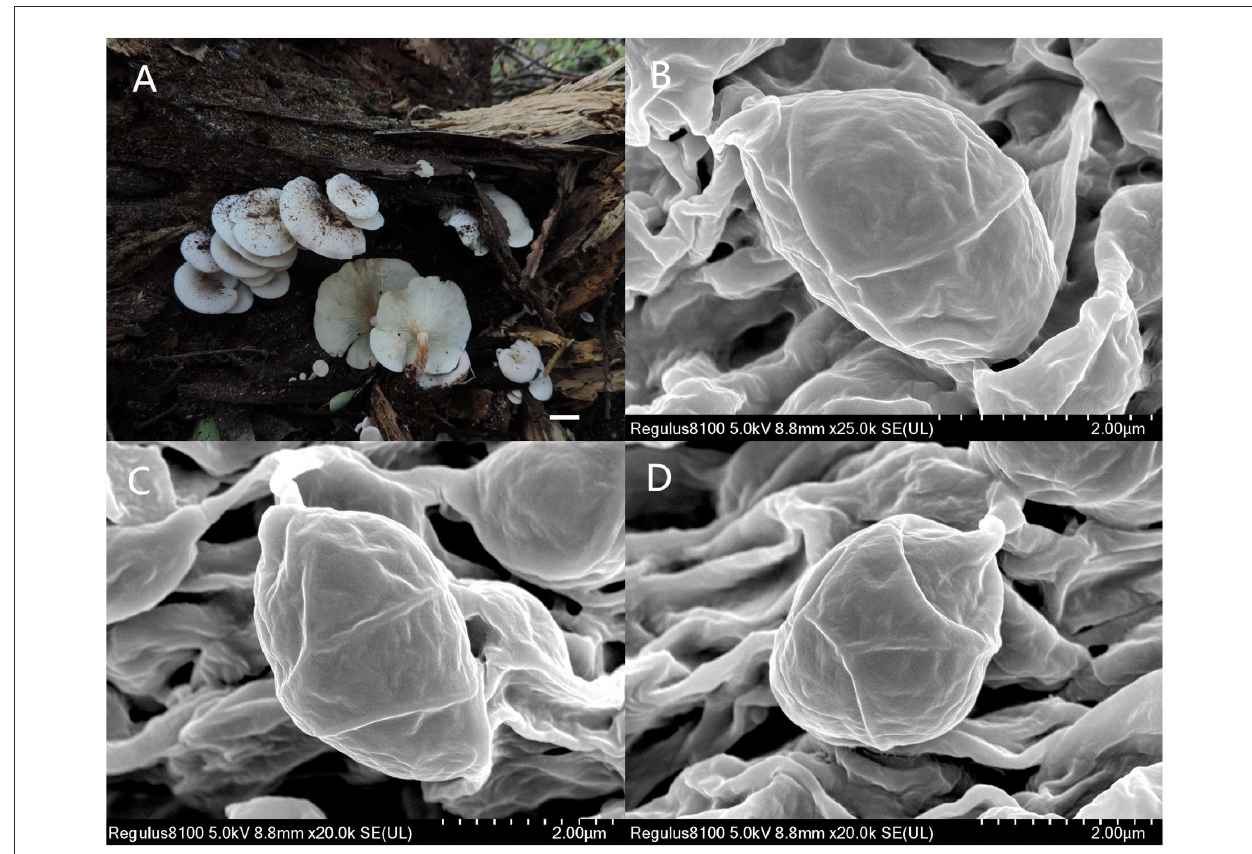
FIGURE6 Ossicaulis borealis (Holotype, SYAU-FUNGI-076). (A) Macroscopic habitat and (B,C,D) surface of basidiospores. Scale bars: 1cm (A) ; 2 µ m (B) .